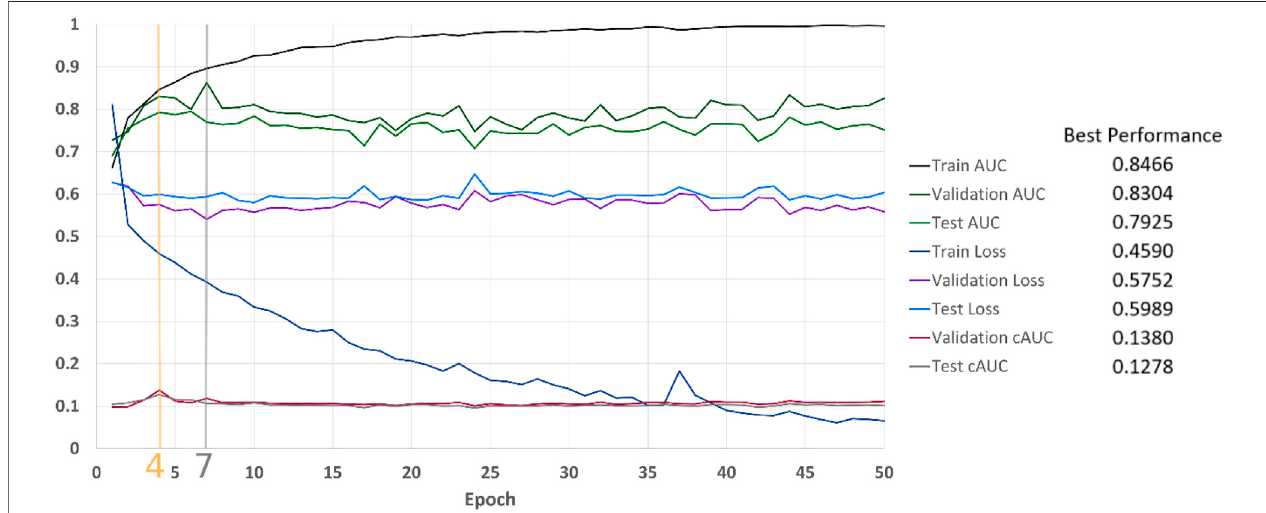
FIGURE 10 | Classi fi cation results on our BraTS-based